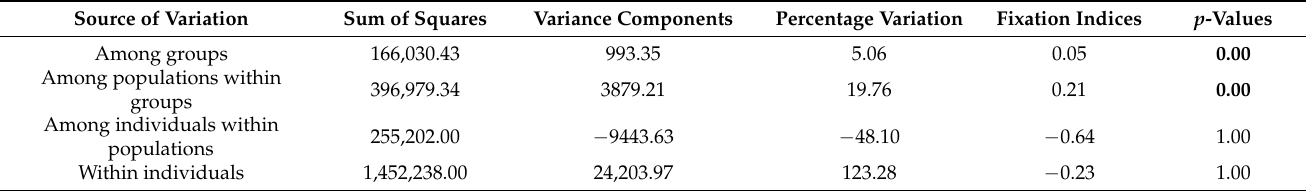
Table 1. Details on the results of the analysis of the molecular variance (AMOVA).